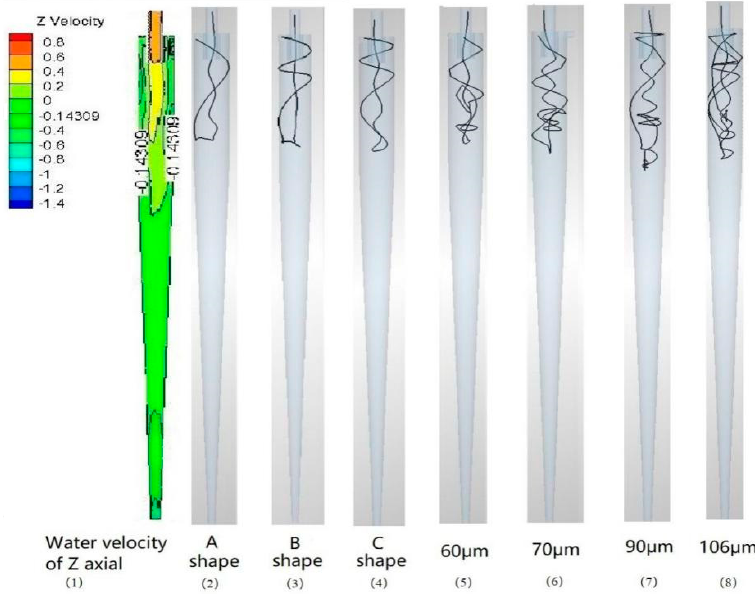
Figure 9. Representative motion tracks of sand particles.